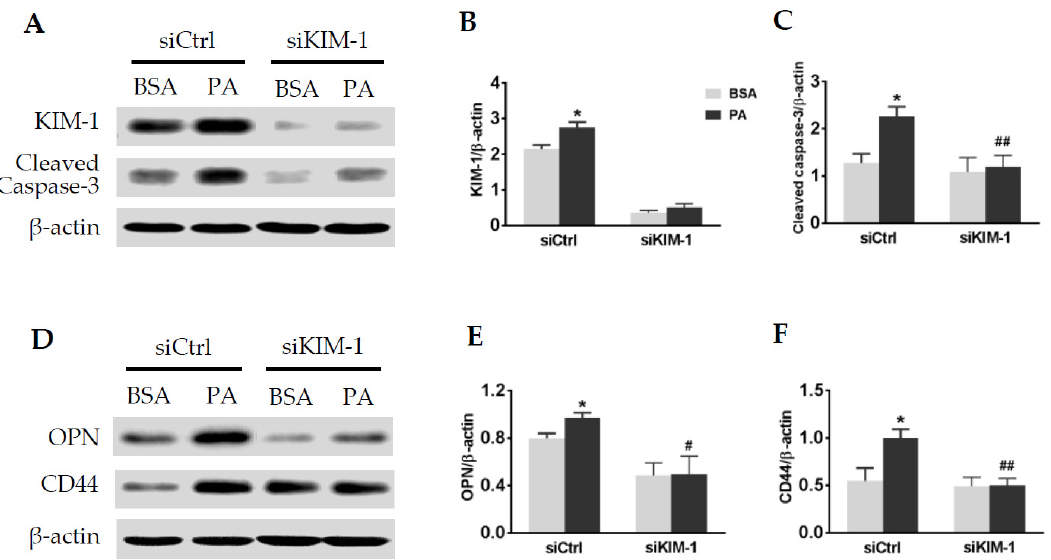
Figure 6. Knockdown of KIM-1 inhibited palmitate-induced cleaved caspase-3, OPN, and CD44 proteins in primary TECs. Knockdown of KIM-1 ( A , B ) by siRNA interference prevented an elevation of cleaved caspase-3 ( A , C ), OPN ( D , E ), and CD44 ( D , F ) upon palmitate stimulation. Values are the mean ± SEM. n = 3–4 individual experiments / group. * p < 0.05 vs. the BSA control; # p < 0.05, ## p < 0.01 vs. the siRNA control (siCtrl).